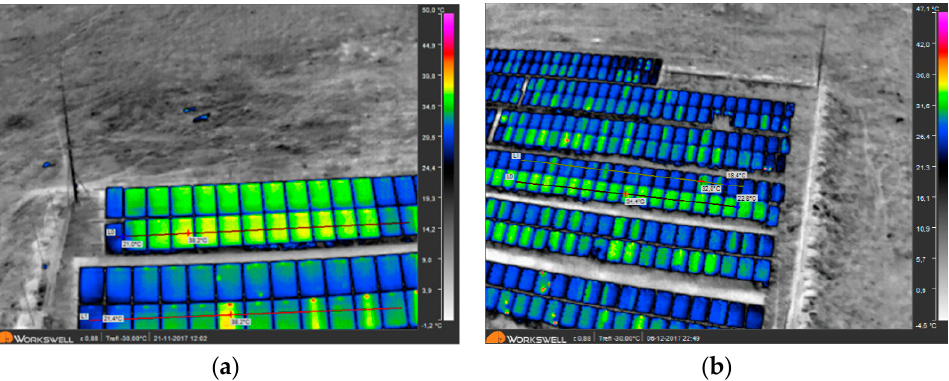
Figure 11. Aerial IR thermographic analysis with an incident of open-circuit PV modules: ( a ) in array 1, and ( b ) in array 4.